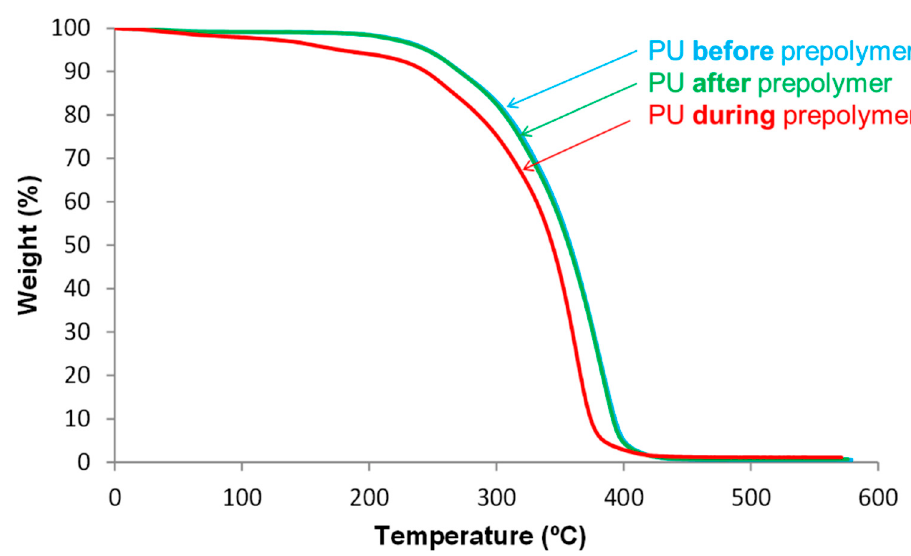
Figure 12. Variation of the weight as a function of the temperature for PU films. TGA experiments. Table 4. Temperatures at which 5 (T 5% ) and 50 (T 50% )% mass are lost in the PU films. TGA experiments.